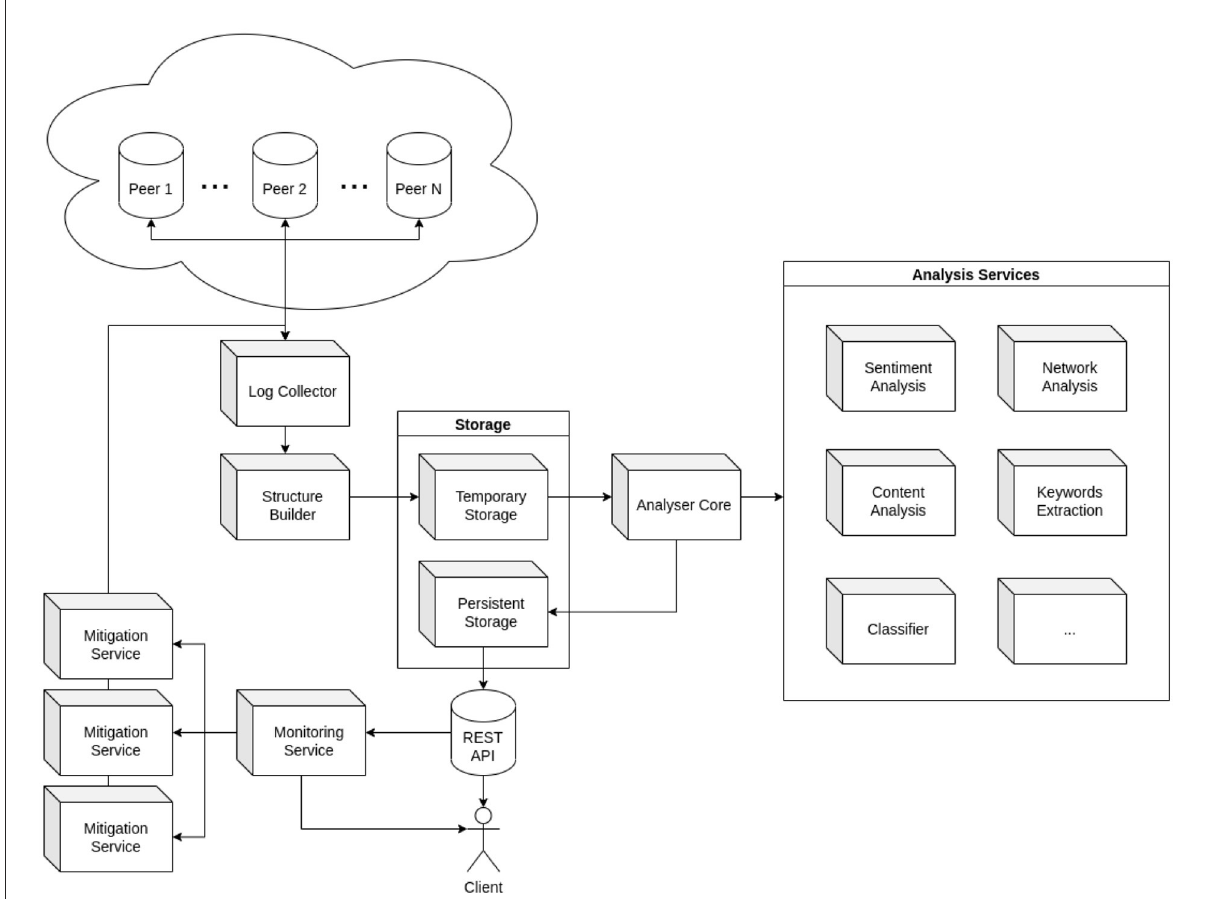
FIGURE1 Generic log auditing architecture for distributed